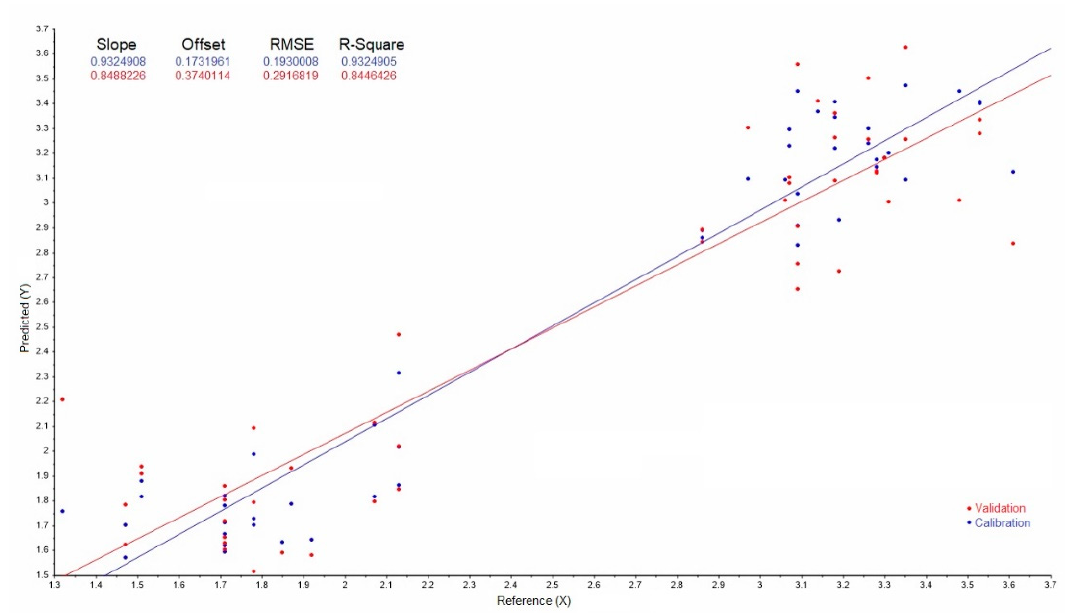
Figure 7. PLS model result for SNV pretreatment method.